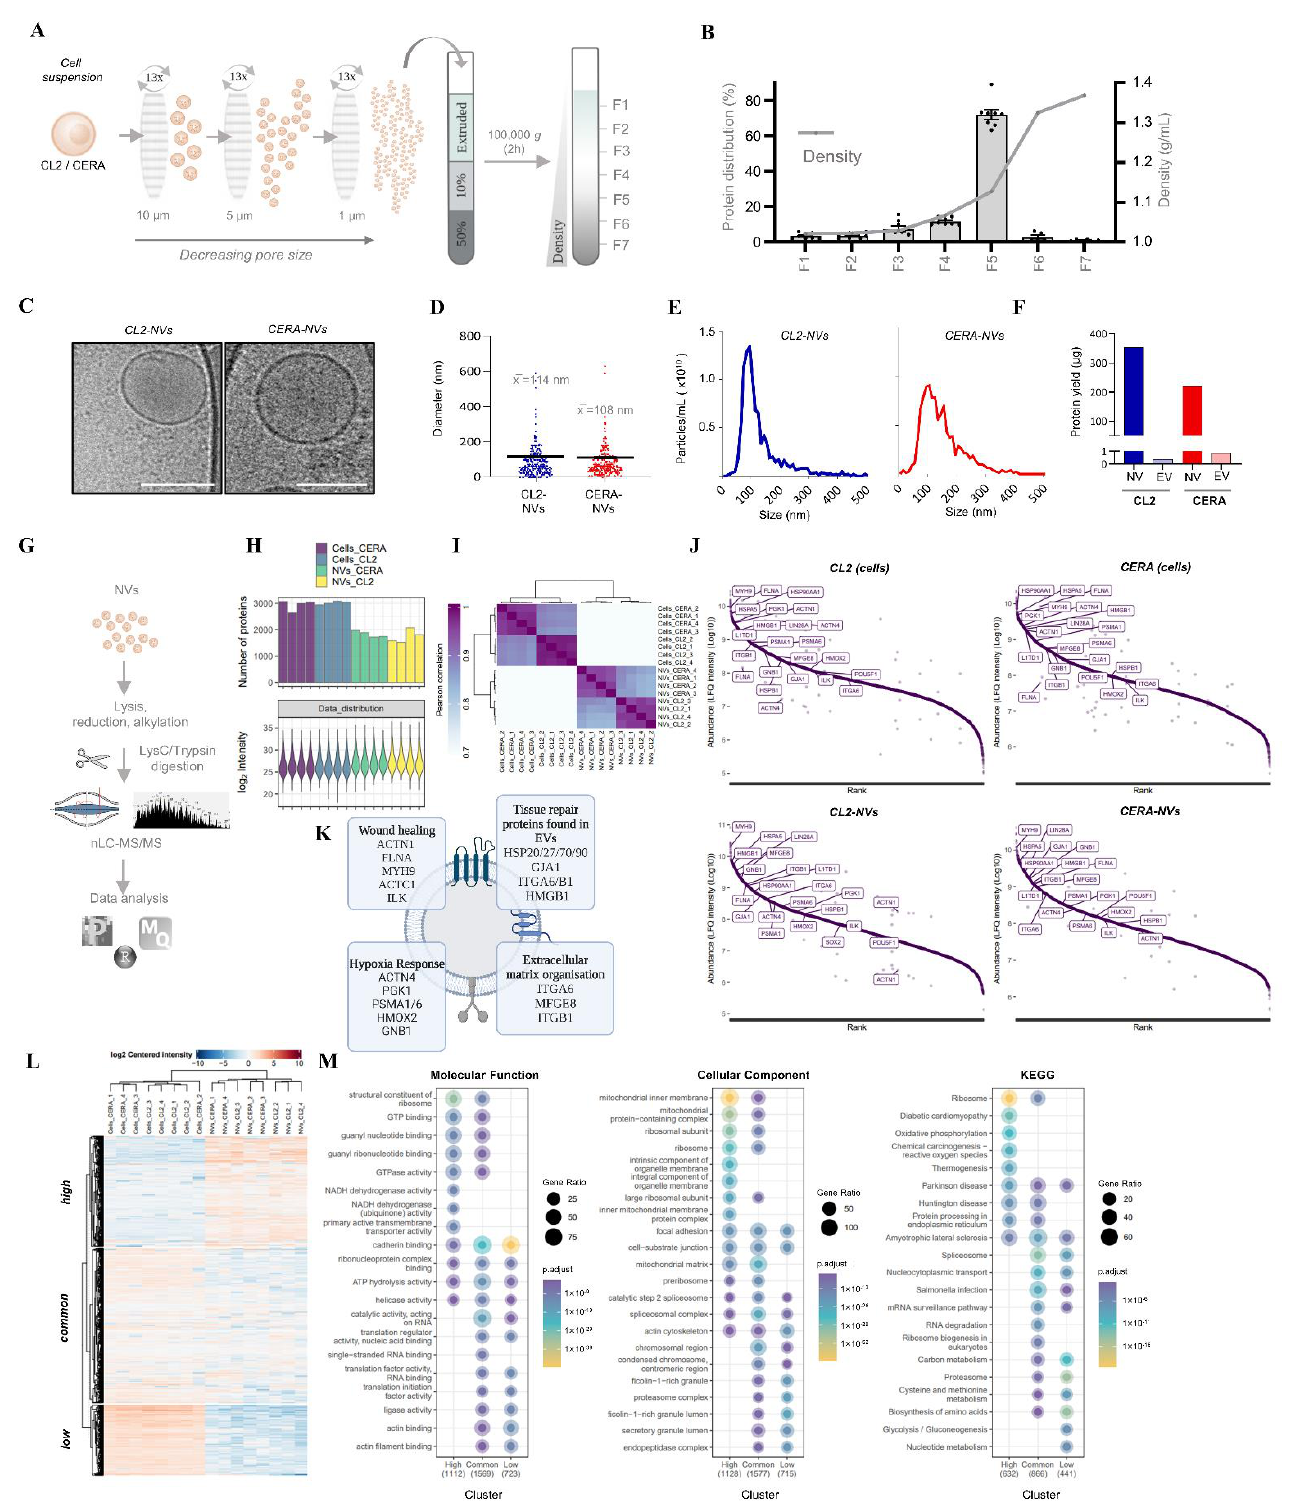
Figure 2. Generation and characterisation of NVs generated from human-induced pluripotent stem cells. ( A ) iPSC nanovesicle generation using serial extrusion (10, 5, 1 µm filter, 13 × each membrane) with the cell suspension purified using density-cushion ultracentrifugation to obtain fractions (F) 1–7 of increasing density. ( B ) The buoyant densities of seven fractions collected for each iPSC preparation were determined by absorbance at 244 nm using a molar extinction coefficient of 320 L g −1 cm −1 . Protein yield determined based on micro-BCA protein quantification (as a % of total), revealing